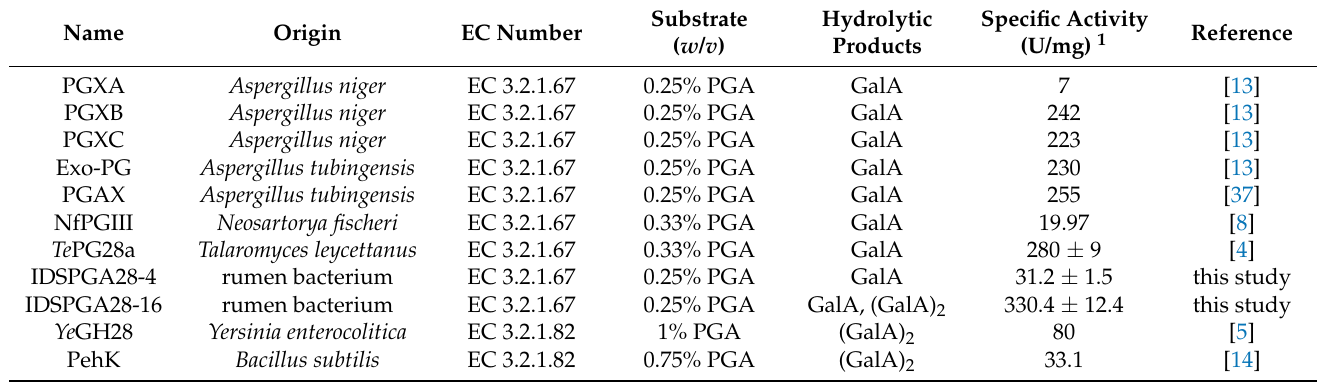
Table 1. Specific activities of exo-polygalacturonases (EC 3.2.1.67) and exo- α -poly- digalacturonosidases (EC 3.2.1.82) against